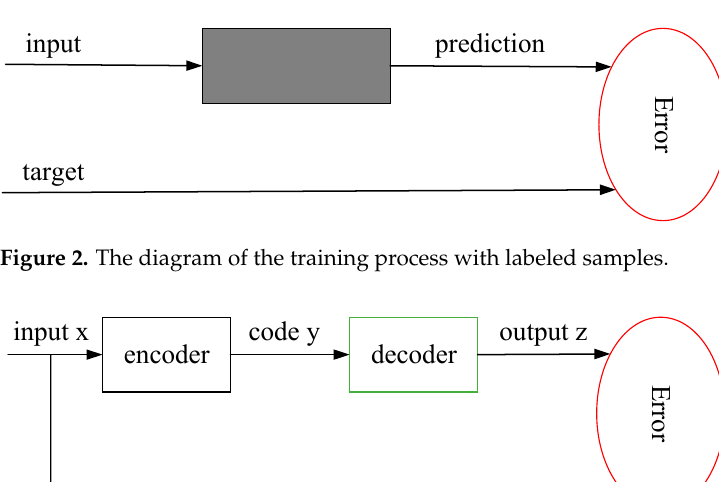
Figure 2. The diagram of the training process with labeled samples.